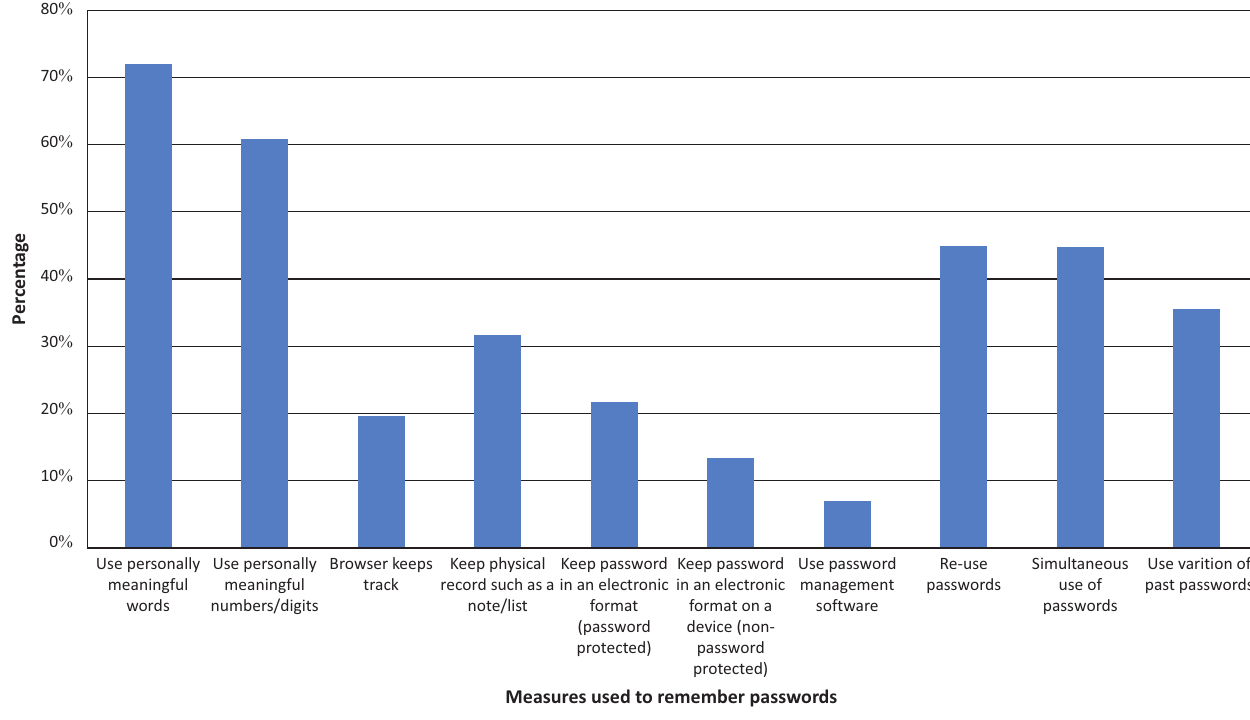
FIGURE 6: Respondents employ various practices to remember passwords.